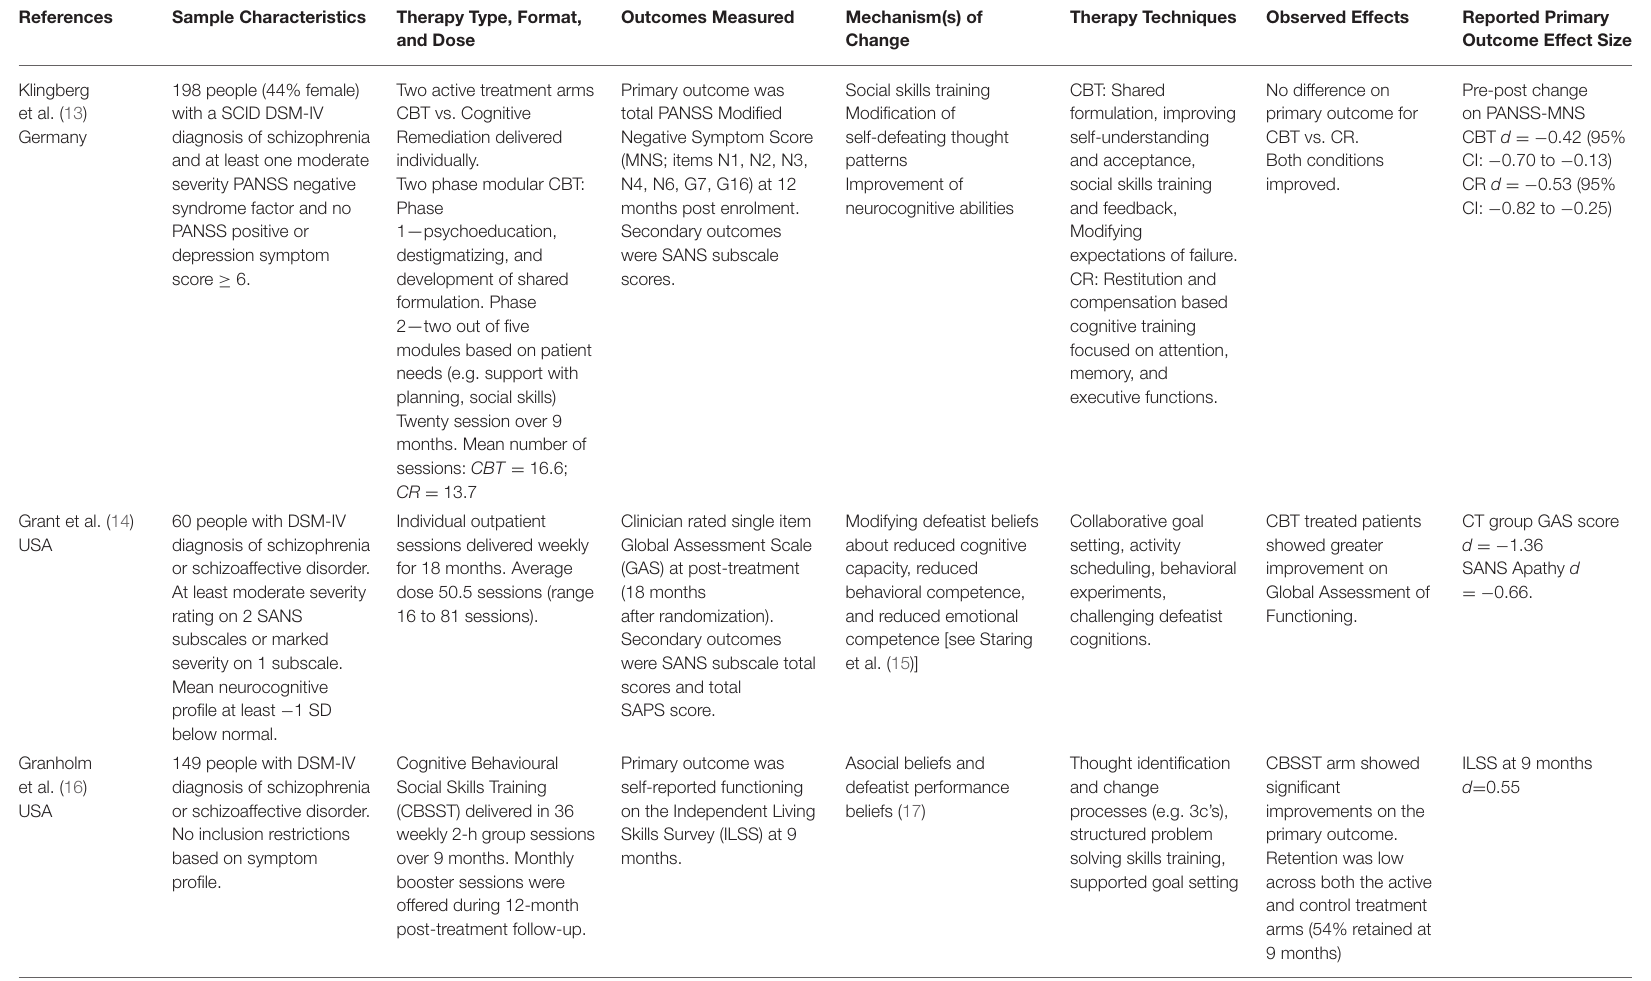
TABLE 1 | A descriptive summary of selected psychological treatment RCTs with negative symptoms specified as a primary or co-primary outcome